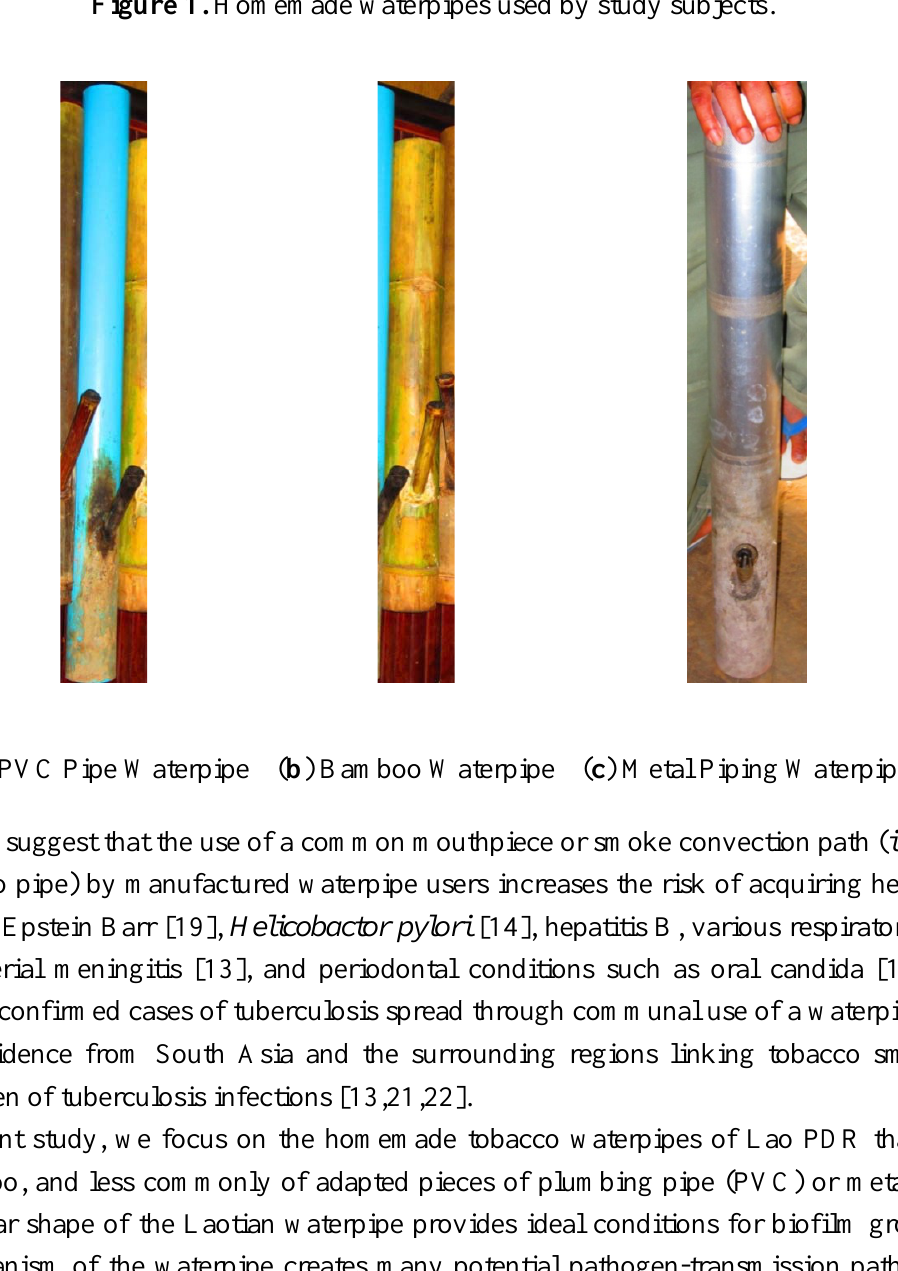
Figure 1. Homemade waterpipes used by study